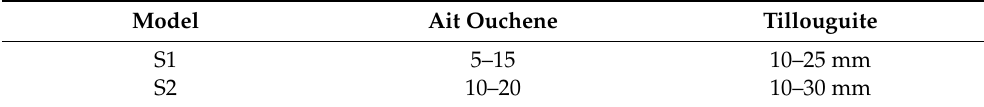
Table 3. Optimal SWE-SCA thresholds providing the best estimates of SCA compared to MODIS. Model